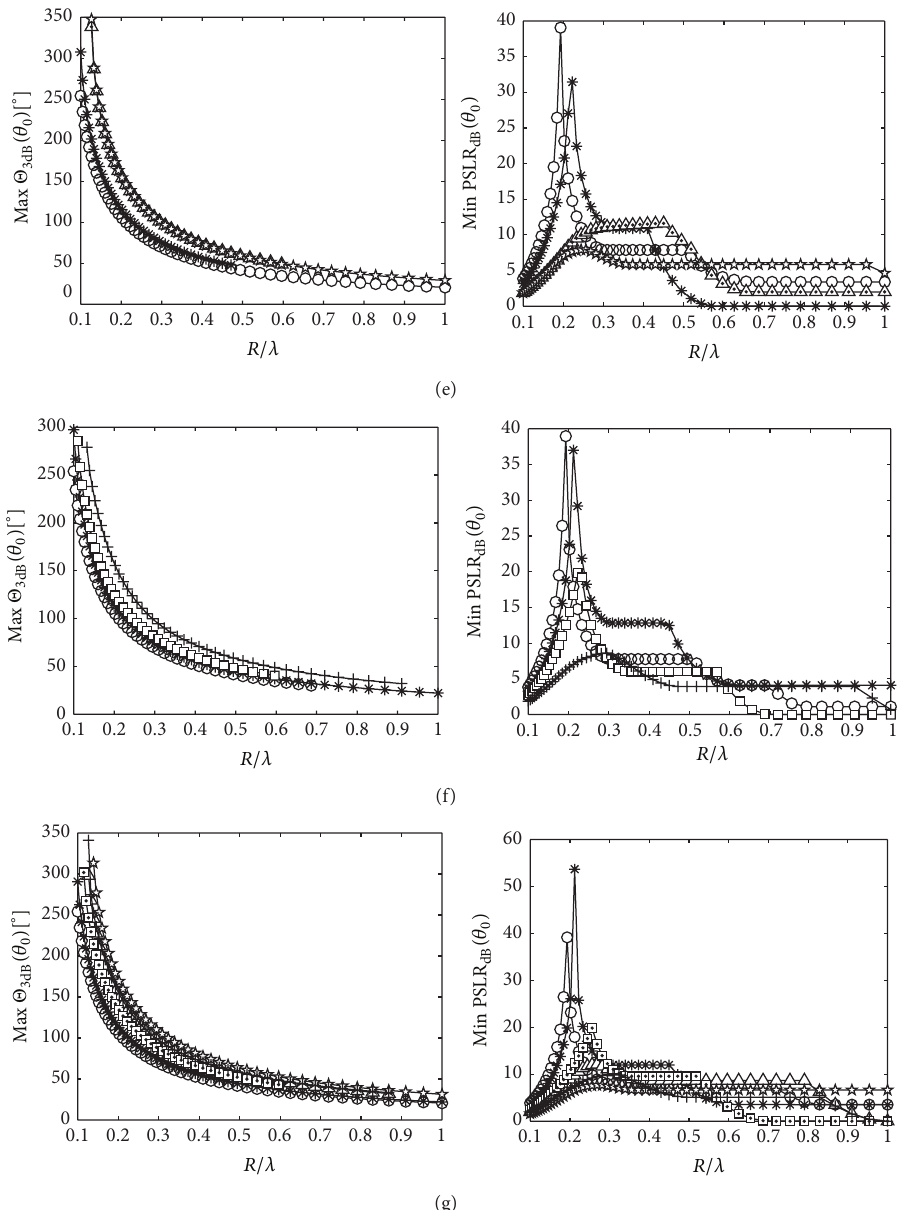
Figure 1: 3 dB aperture (left) and PSLR (right) for the configurations of Table 1: (a) 3-element configurations, (b) 4-element configurations, (c) 5-element configuration, (d) 6-element configurations, (e) 7-element configurations, (f) 8-element configurations, and (g) 9-element configurations. The legend is given in the lower row of Table